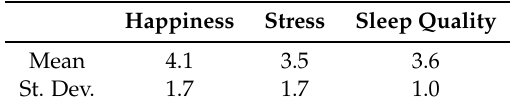
Table 4. Pre-study self-reported measures (Likert Scale: 1 (bad) to 7 (excellent)).